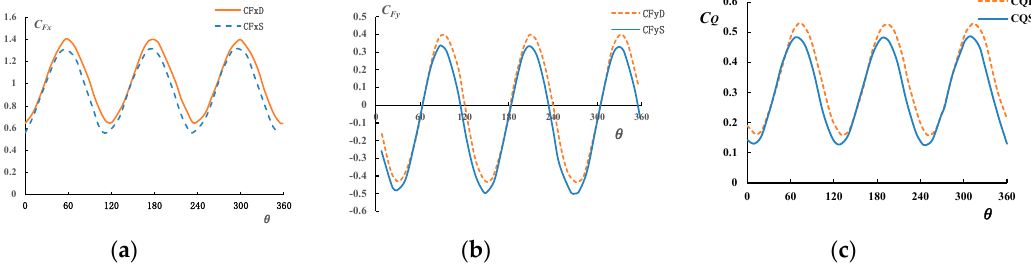
Figure 14. Lateral force, thrust and torque coefficient curve, ( a ) thrust coefficient curves of stand-alone turbine and twin-rotors system, ( b ) lateral force coefficient curves of stand-alone turbine and twin-rotors system, ( c ) torque coefficient curves of stand-alone turbine and twin-rotors system.